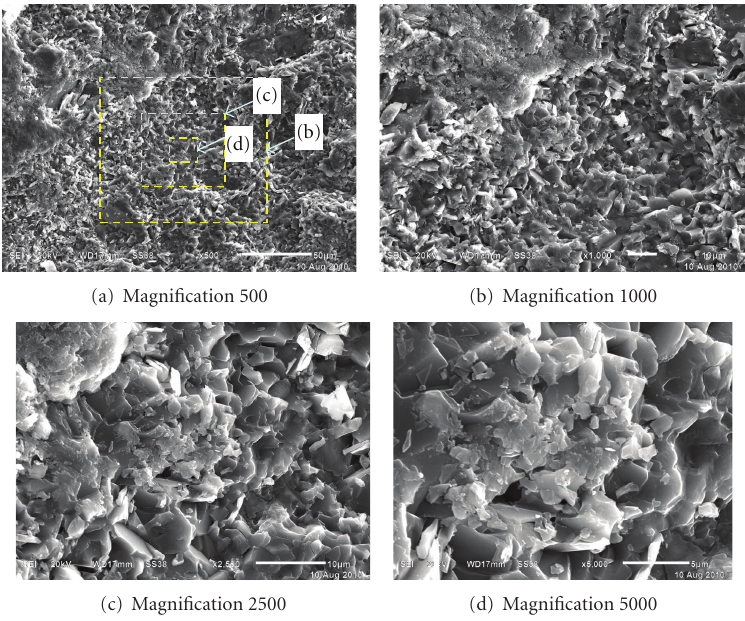
Figure 3: SEM images of black diabase with di ff erent